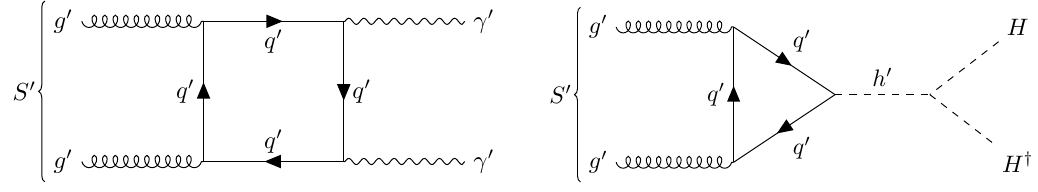
Figure 6 . Mirror glueball decay to (cid:13)